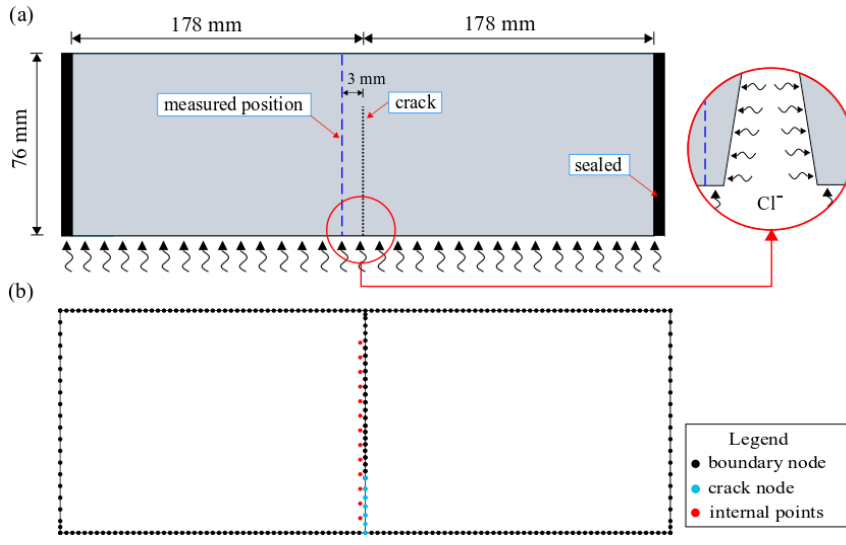
Figure 4. (a) Specimen geometry, (b) BEM mesh.